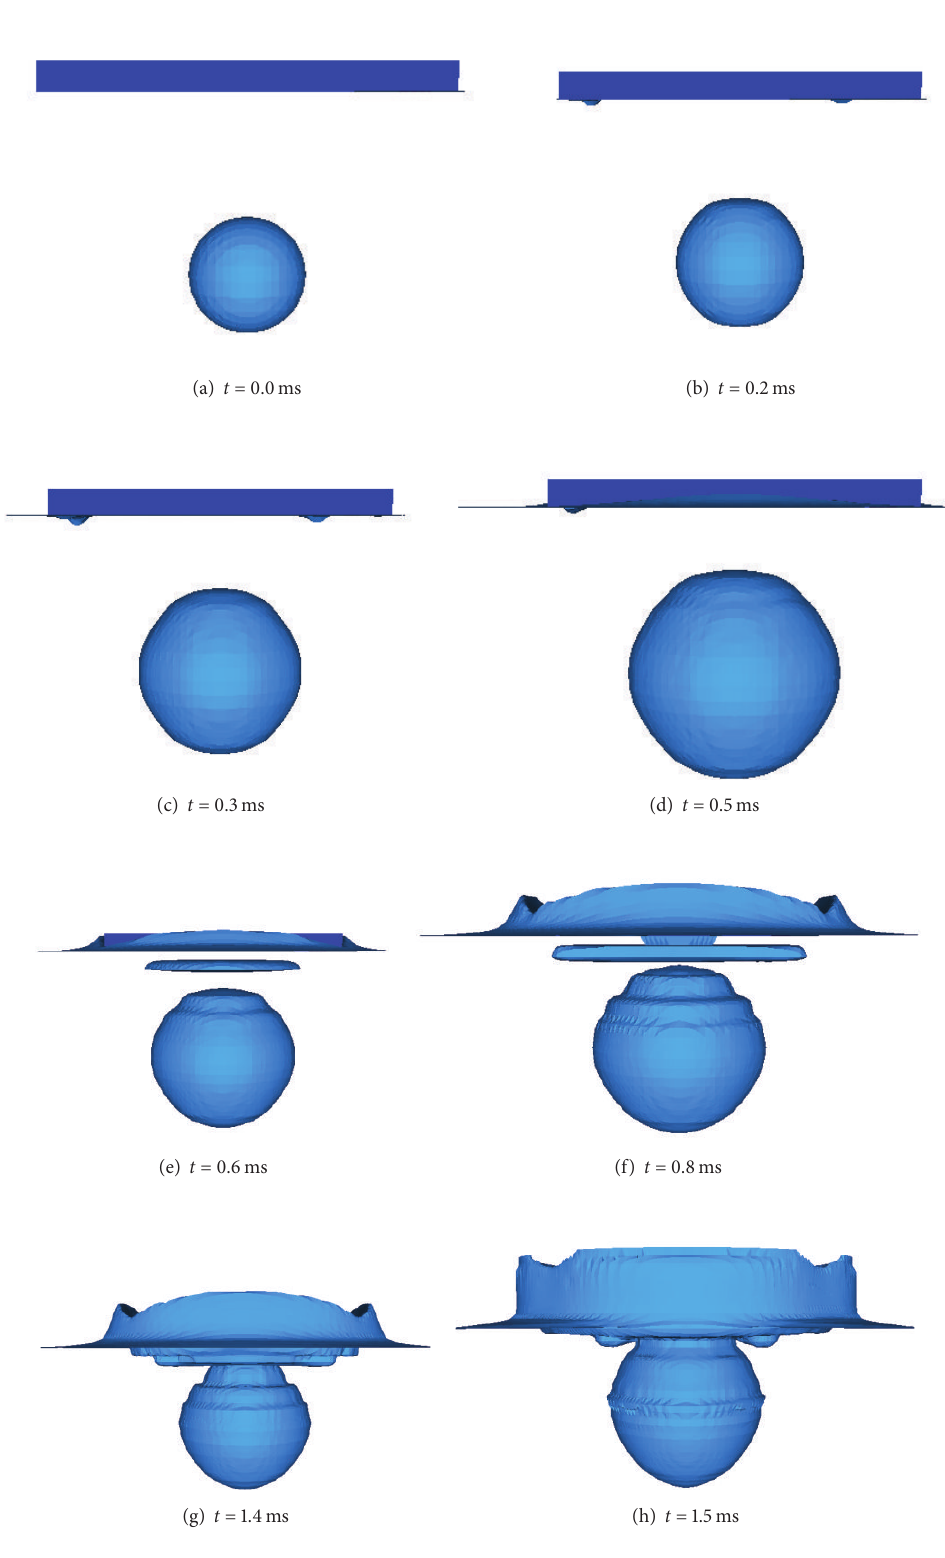
Figure 19: Bubble shape state of case 3 ( W = 5.00 kg, d = 0.6